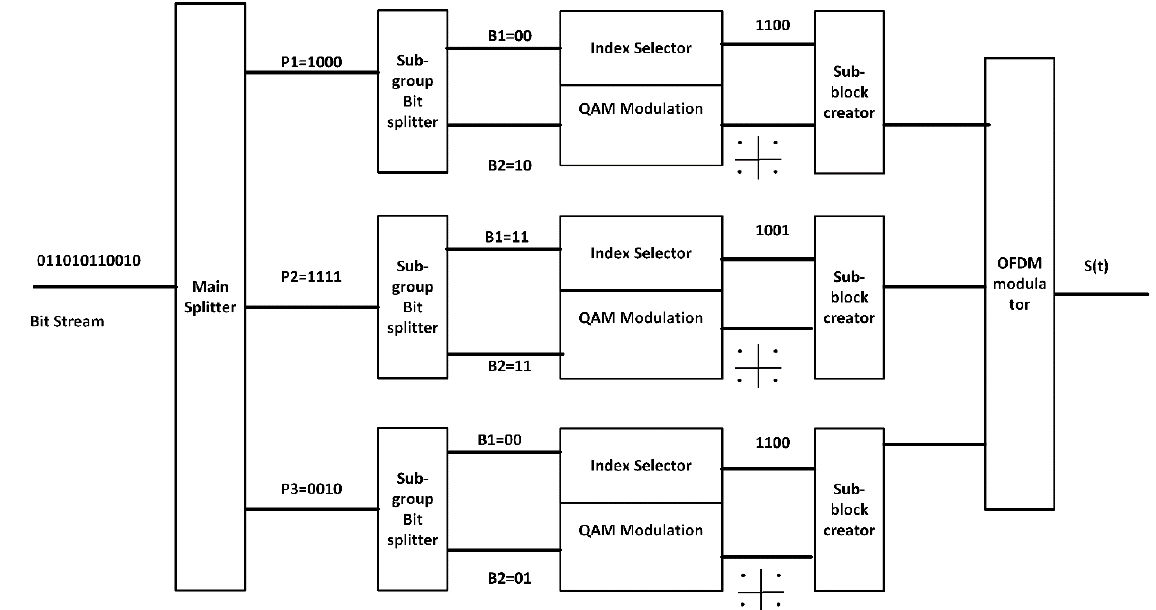
Figure 1. System block diagram of SIM OFDM transmitter.